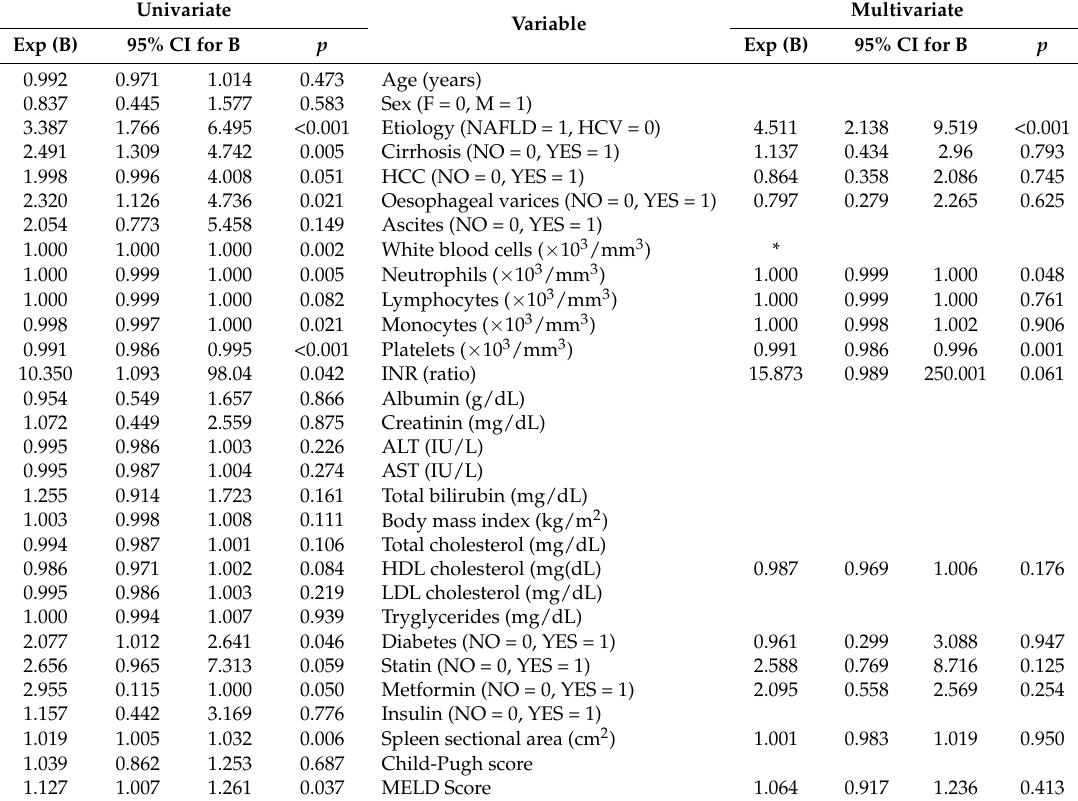
Figure 1. Activity of lysosomal acid lipase (LAL) as measured on peripheral blood of patients with with non-alcoholic fatty liver disease (NAFLD) and hepatitis C virus (HCV)-related chronic liver disease. Table 2. Univariate and multivariate binary logistic regression analysis to lysosomal acid lipase (LAL) in the study population as a whole (performed using LAL below median as the dependent variable). Univariate Variable